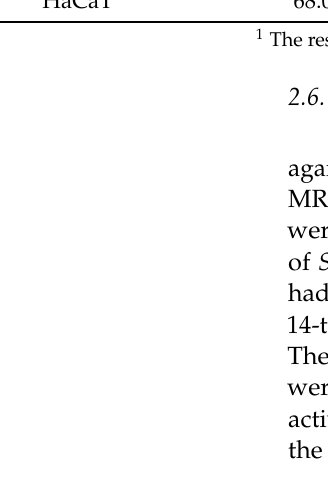
Table 5. The MBICs and minimum biofilm eradication concentrations (MBECs) of Brevinin-2GUb and its derivatives 1 . Bacteria